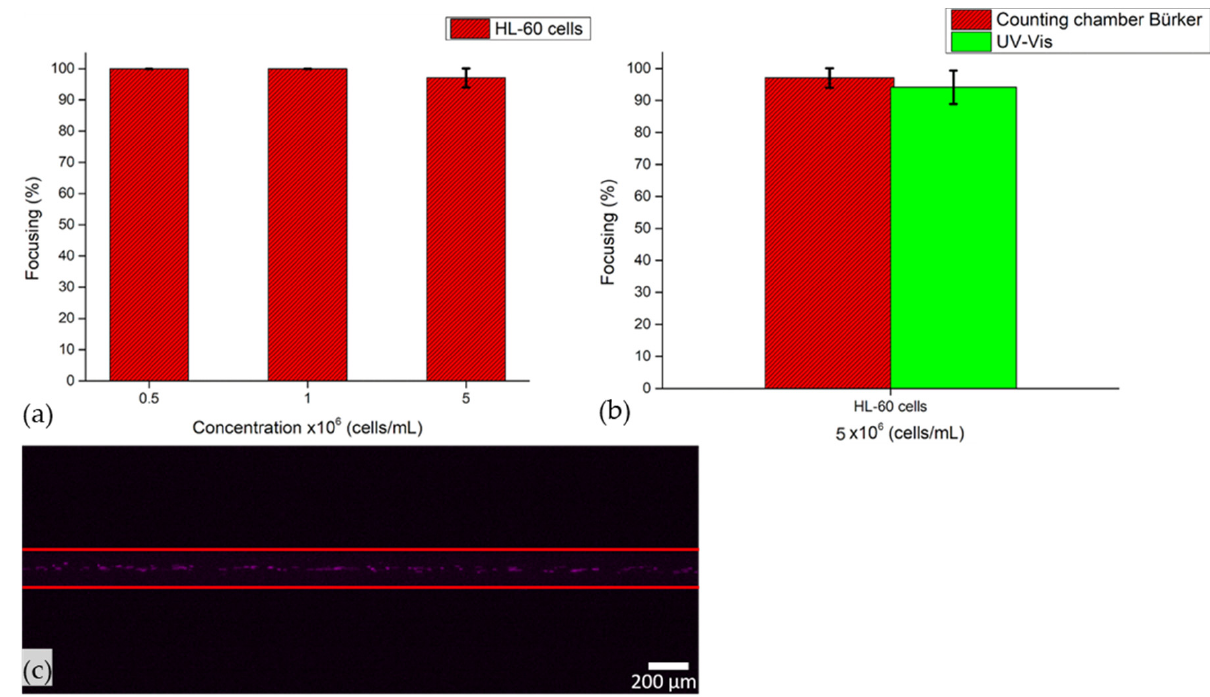
Figure 11. Focusing performance of the BAW device as a function of cell concentrations from Bürker counting chamber analysis. ( a ). Cells were injected at 3 µ L/min when 50.59 Vpp was applied to the transducer, while the device was actuated at its resonance frequency of 4.623 MHz. ( b ) Focusing performance of the BAW device from Bürker counting chamber analysis and UV–Vis characterization. HL-60 cells concentrated at 5 × 10 6 cells/mL were injected at 3 µ L/min when 50.59 Vpp was applied to the transducer, while the device was actuated at its resonance frequency of 4.623 MHz. ( c ) Frame of time lapse acquired during the acoustophoretic test, when HL-60 cells concentrated at 5 × 10 6 cells/mL were injected at 3 µ L/min, 50.59 Vpp was applied to the transducer and the device was actuated at its resonance frequency of 4.623 MHz. Image acquired with 4 × objective lens with an exposure time of 30 ms.